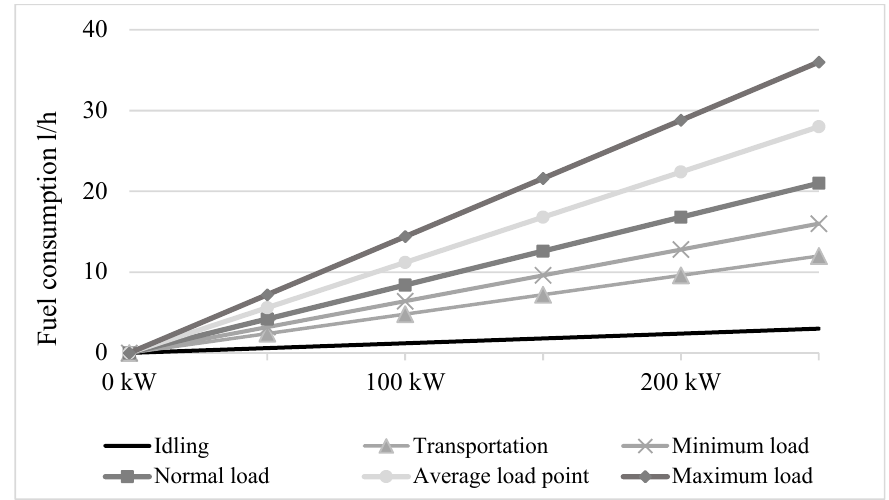
Figure 4. Correlation between fuel consumption and agricultural machinery power for different load application points [28].